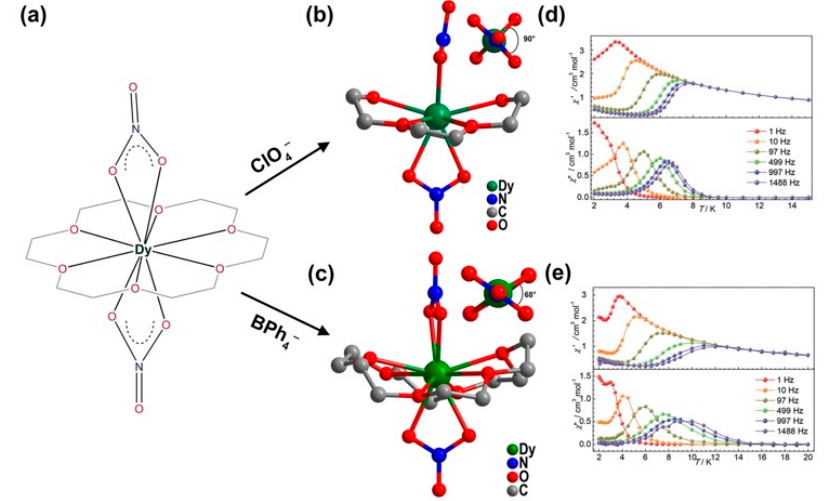
Figure 10. Scheme sketch ( a ), for side view ( b ) for 14 and ( c ) for 15 ) of [Dy(18-crown-6)(NO 3 ) 2 ] + cation. Inset: dihedral angles for apical bidentate nitrate anions, ( d ) and ( e ) Temperature-dependence of the in-phase ( χ ’) and out-of-phase ( χ″ ) AC susceptibility signals under 1000 Oe DC field at the indicated frequencies for complexes 14 and 15 . Lines are visual guides only. Figures and captions are reproduced from Reference [43] with permission from the Royal Society of Chemistry.